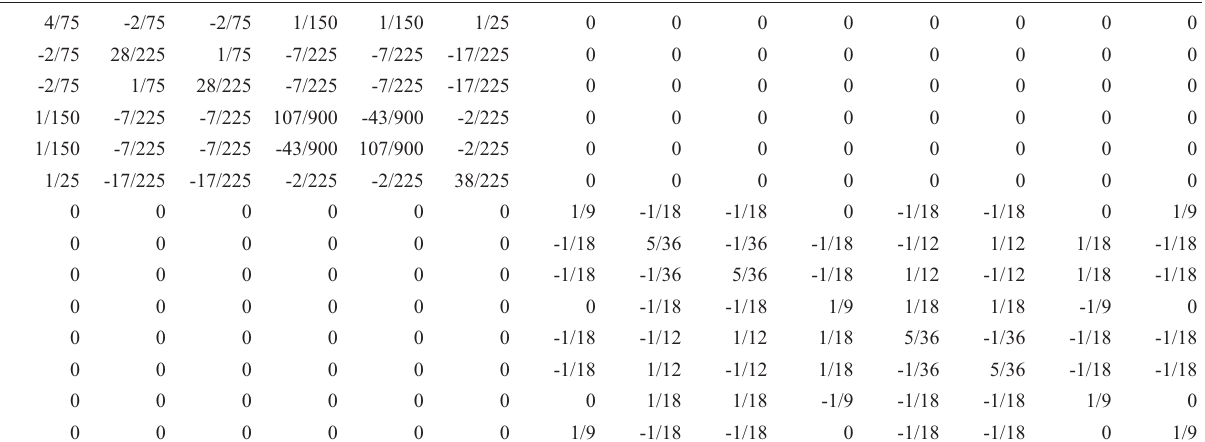
Table 14 - Estimates of the variances and covariances of the effects for an incomplete diallel model (Case 3, type 1 constraints) calculated using a matrix